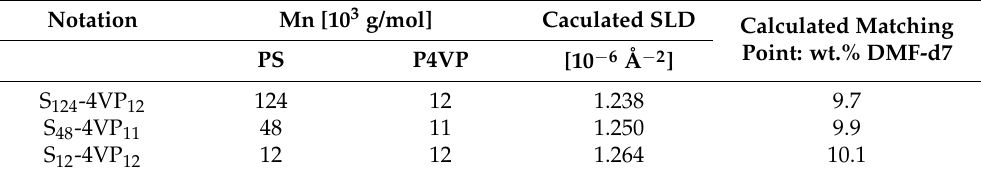
Table 8. Molecular weight, calculated SLD, and matched solvent content of S4VP block copolymers of varying PS block